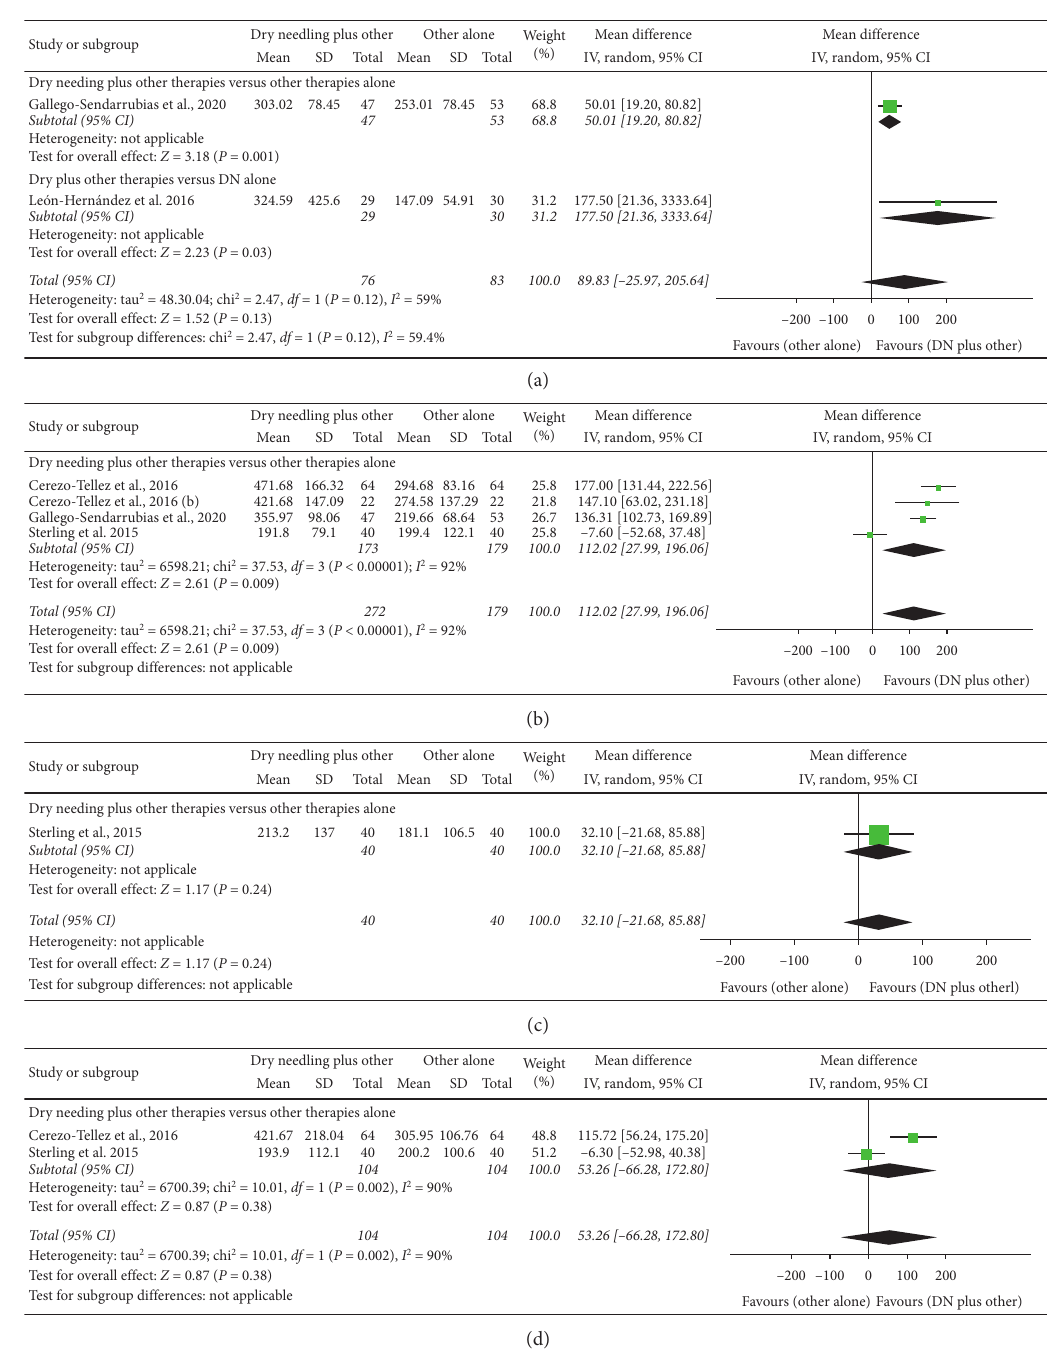
Figure 5: Comparison (mean differences) between the effects of dry needling combined with other interventions against other interventions on pressure pain thresholds (a) immediately after, (b) at short-term, (c) at midterm, and (d) at